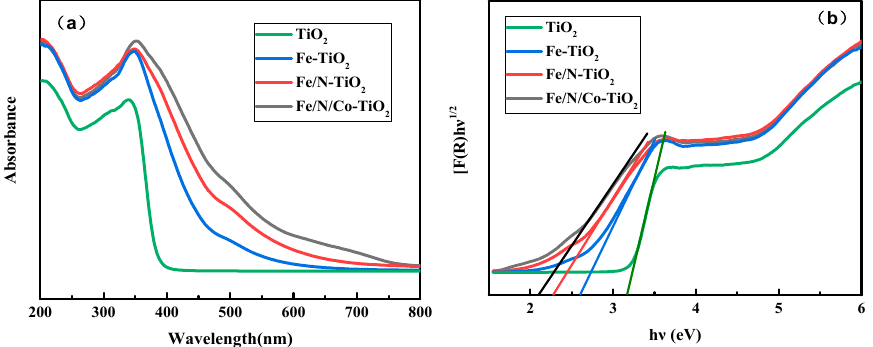
Figure 3. The UV-Vis absorption ( a ) and corresponding plot of transformed Kubelka–Munk function pattern ( b ) of TiO 2 , Fe, Fe/N, and Fe/N/Co–TiO 2 particles after calcination at 650 °C.